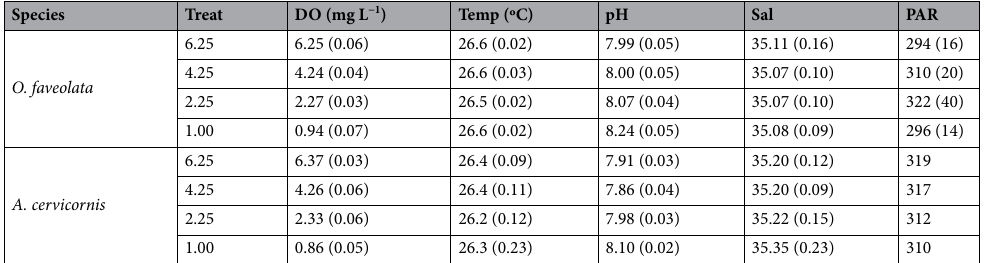
Species DO (mg L −1